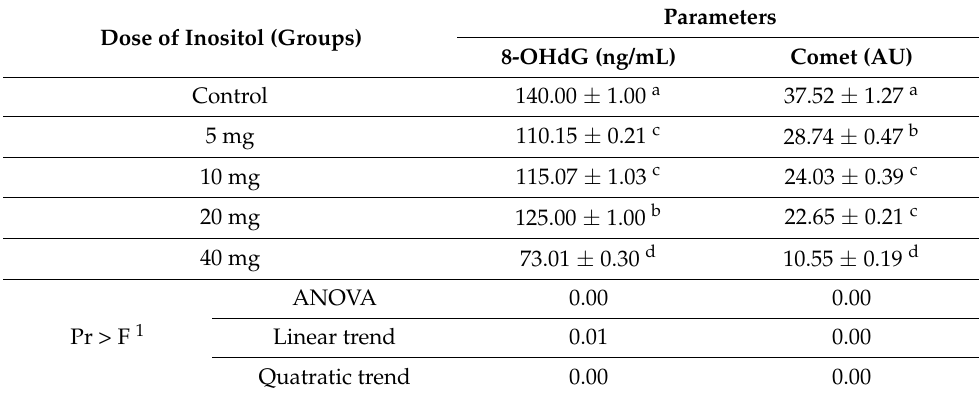
Table 3. DNA damage of S. triostegus after thawing using comet assay and 8-hydroxydeoxyguanosine (8-OHdG) (mean ± SE, n = 7).